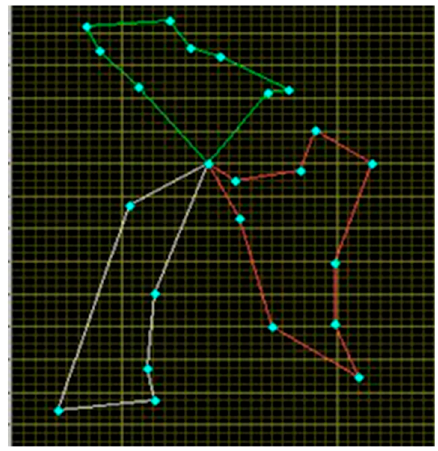
Figure 15. Optimal path generated for using three vehicles.